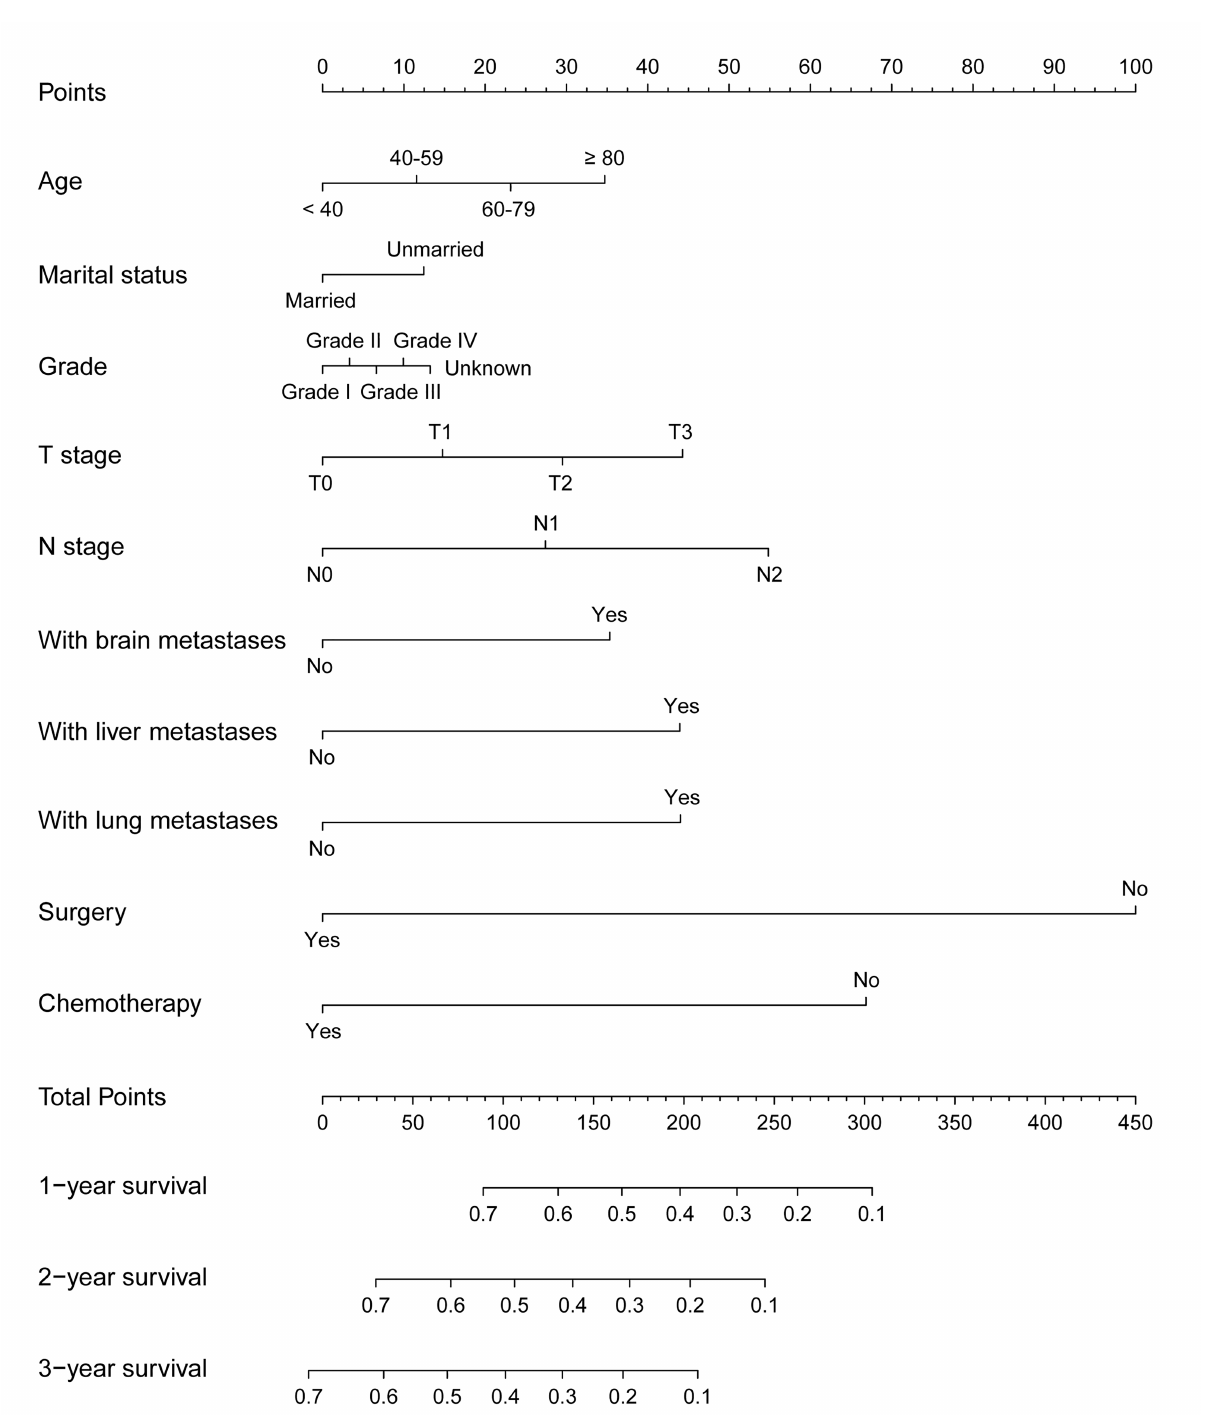
Figure 3 - The 1-, 2-, and 3-year nomogram model for cancer-specific survival (CSS) for patients with bone metastatic